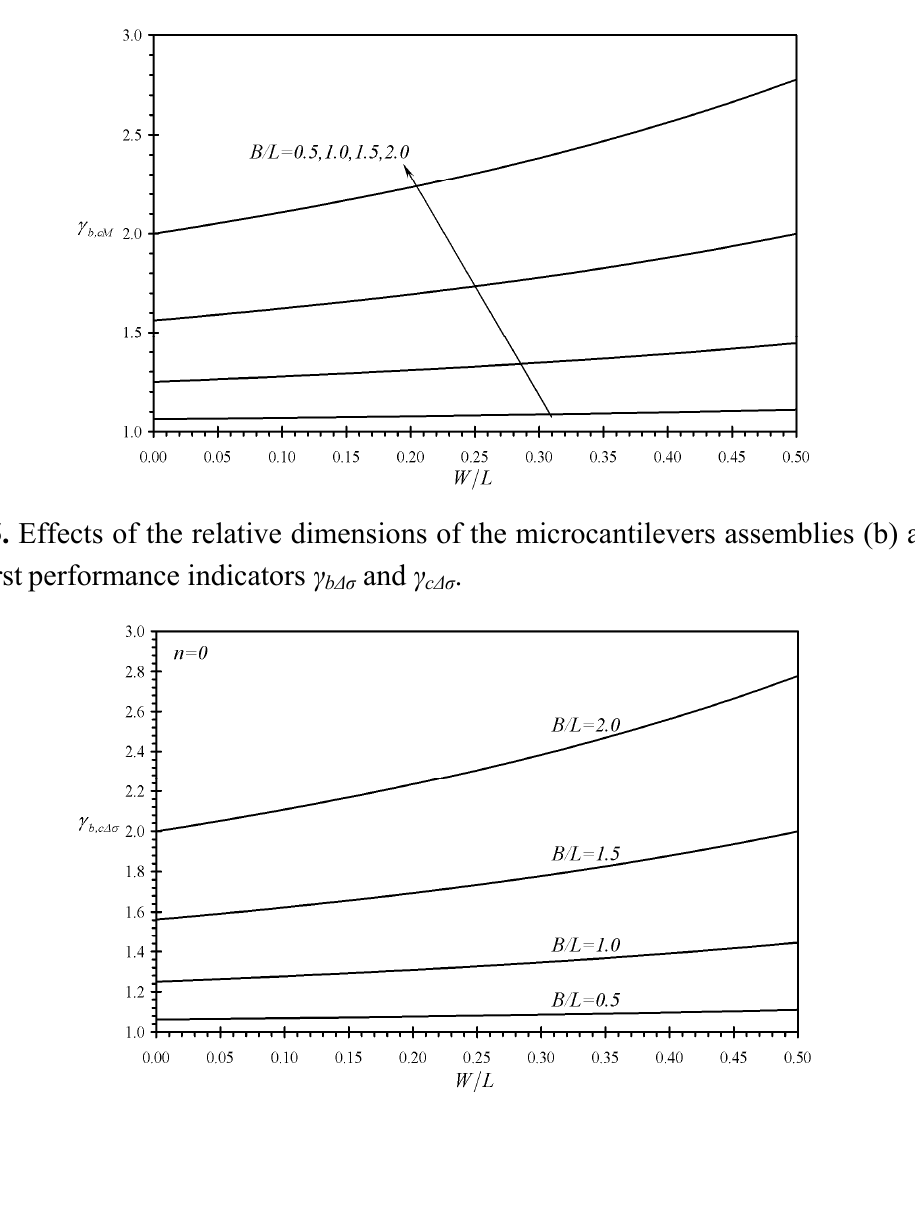
Figure 4. Effects of the relative dimensions of the microcantilevers assemblies (b) and (c) on the first performance indicators γ